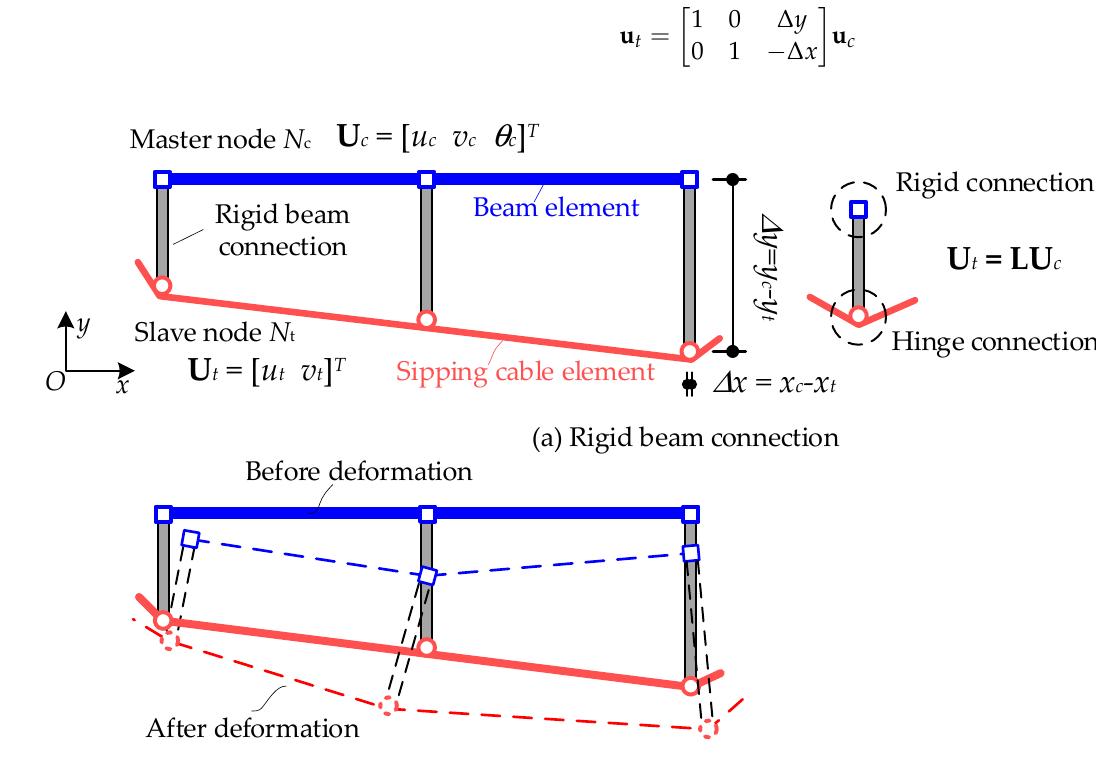
Figure 6. Rigid beam connection between beam and tendon.